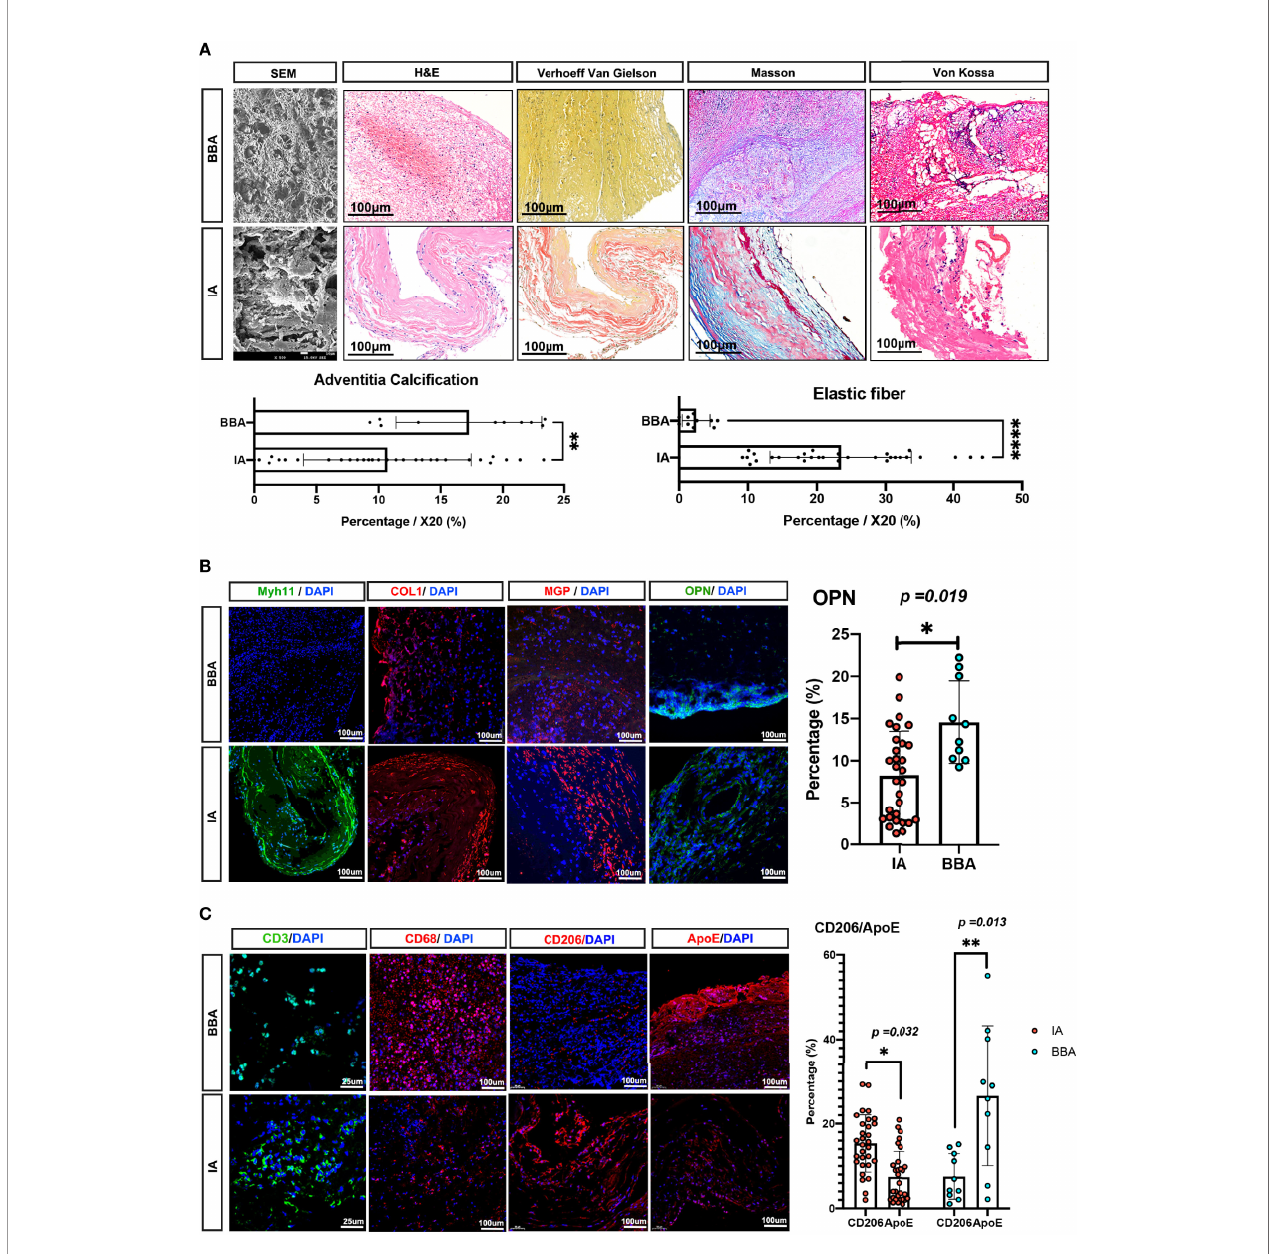
FIGURE 6 | Pathological validations of blood blister-like aneurysm (BBA) and intracranial aneurysm (IA) differences. (A) Pathological differences between IAs and BBAs, with statistical analysis. All scale bars are noted in the fi gures. (B, C) Immuno fl uorescence validation between IAs and BBAs; scale bars are noted in the fi gures. *Statistically signi fi cant; p -values were also noted in the plots, *p-value < 0.05, **p-value < 0.01, ***p-value < 0.001, ****p-value <